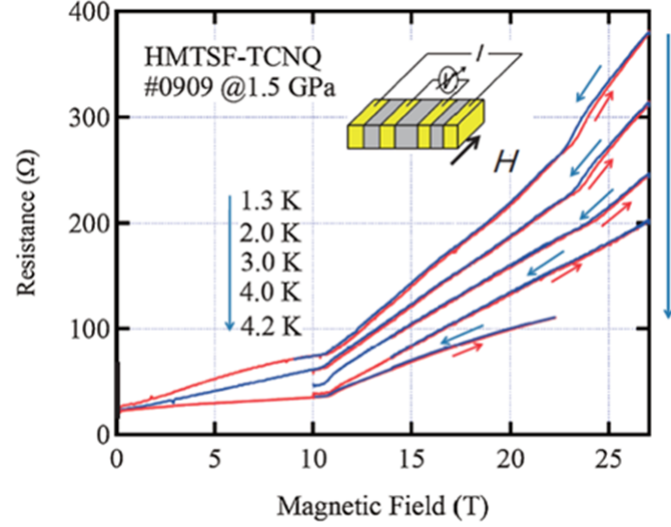
Figure 2. Magnetoresistance, which shows field-induced CDW state in HMTSF-TCNQ. Pressure at low temperature may be around 1.3 GPa at low temperature with 1.5 GPa at room temperature and with Daphne 7373 pressure medium in a piston cylinder cell